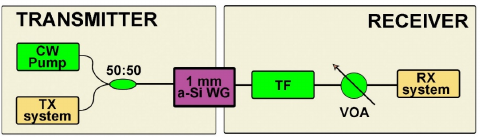
Figure 4. Wavelength conversion experiment set-up. TF: Tunable filter. CW: Continuous Wave; TX: Transmitter [26].